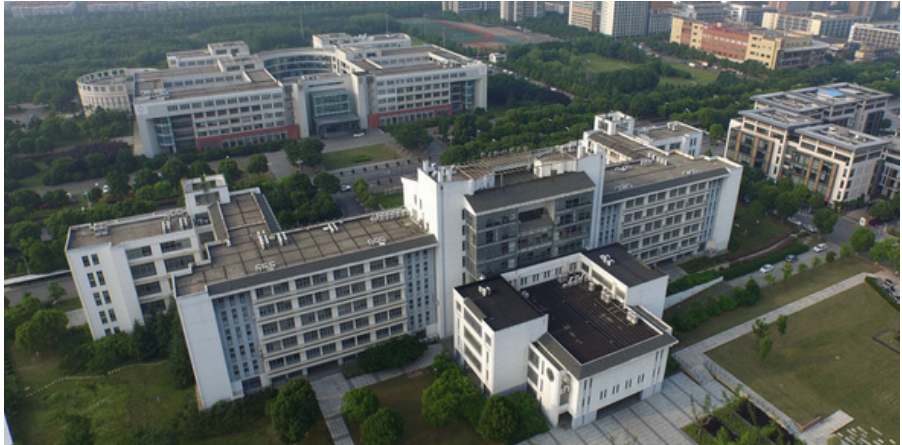
Figure 1. Sample building photo (author original).